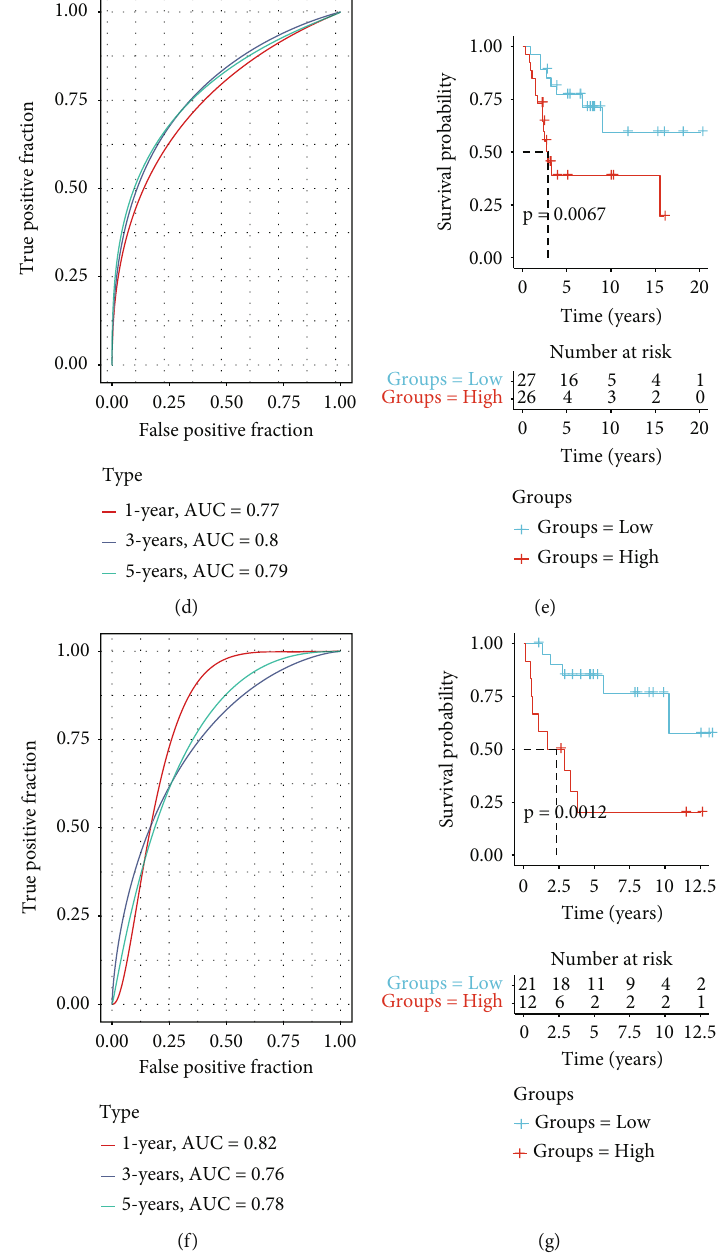
Figure 5: The ARG-based risk signature ’ s prognostic importance in osteosarcoma. (a) The distribution of patient longevity status and risk score, and the expression pro fi les of nine aging genes in high- and low-risk groups in the TGGA cohort. (b, d, and f) The receiver operating characteristic curves for forecasting OS in TCGA, GSE21257, and GSE16091 cohorts, respectively. (c, e, and g) The survival curves for patients with high risk score and low risk score in the TCGA